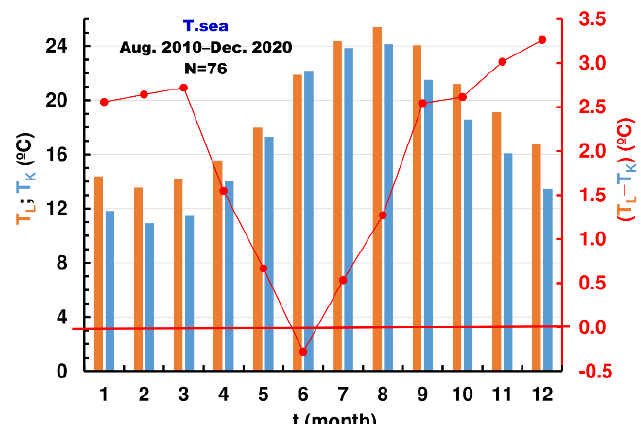
Figure 9. Histograms of the average values of the mean monthly sea surface temperatures at Lastovo (brown) and Krk (blue) and their differences (red) from August 2010 to December 2020, for the months when measured at both stations.